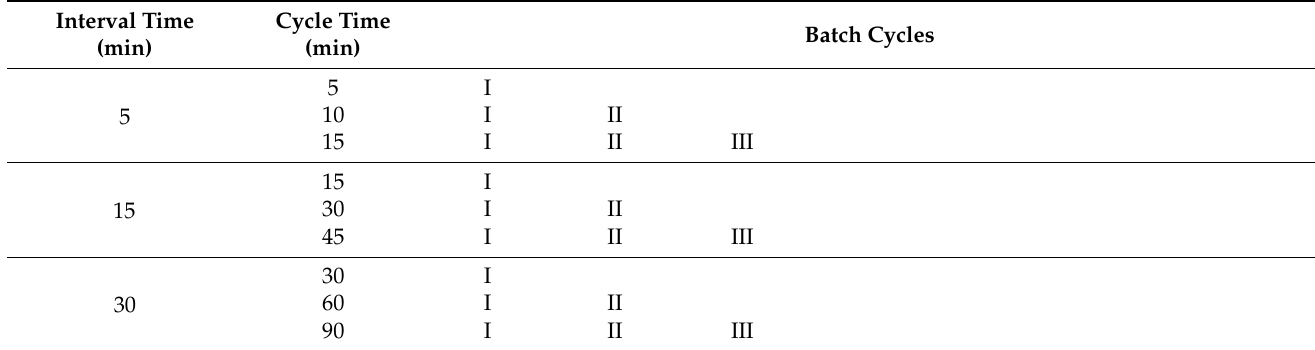
Table 1. Process times for WAO and